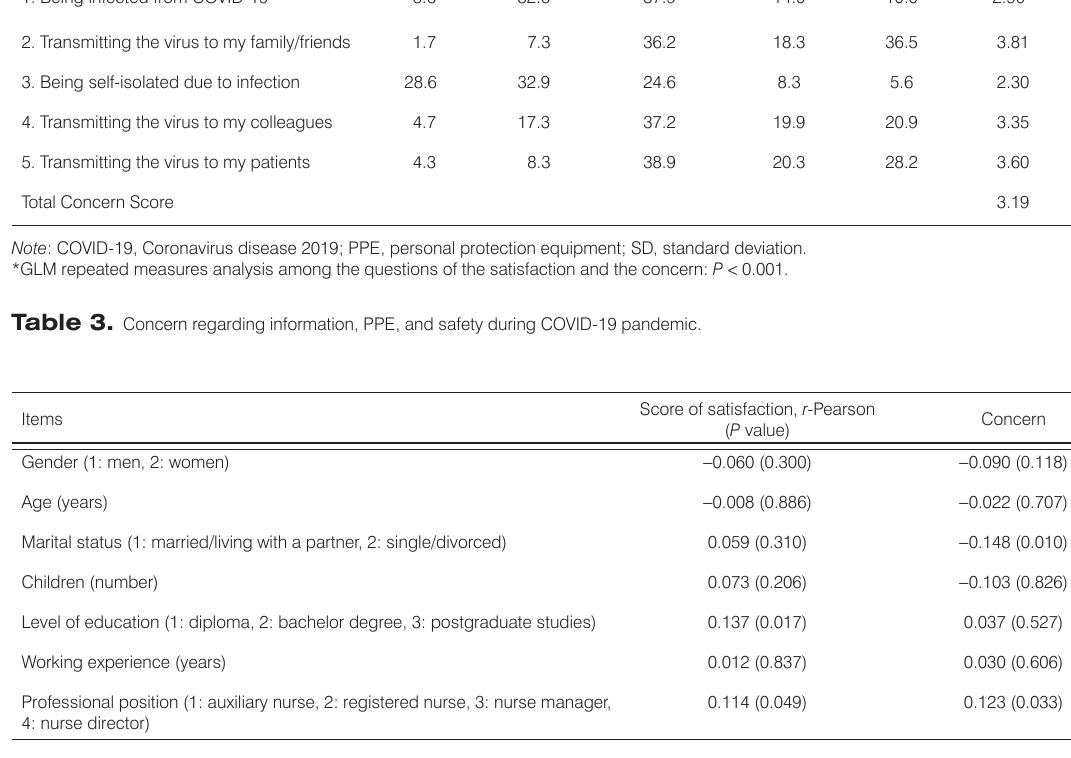
Table 4. Pearson correlation between overall Satisfaction and Concern scores participants’ characteristics. On the contrary, Hoseinabadi et al. 31 emphasize that outbreaks may be a factor in preventing nurses’ burn- burnout levels appeared to be higher for frontline nurses out. In addition to that, Manzano and Ayala 20 demon - compared to those who work in usual wards. Neverthe- strate that organizational support, such as clear, fluid, less, the authors state that work related stress signifi- and regular communication with the nursing staff, would cantly influences the burnout levels, while the sense of help increase nurses’ confidence and sense of control successfully controlling ongoing and future pandemic and thus prevent work related burnout.